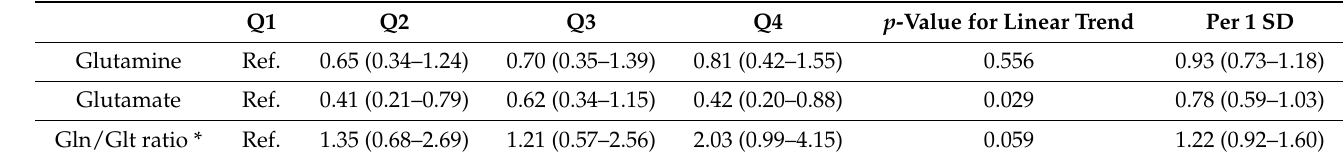
Table 5. Association between plasma glutamine–glutamate pathway metabolites and incident of peripheral artery disease (PAD). Multivariable model adjusted for the intervention group, body mass index, smoking, leisure-time physical activity, education level, dyslipidemia,